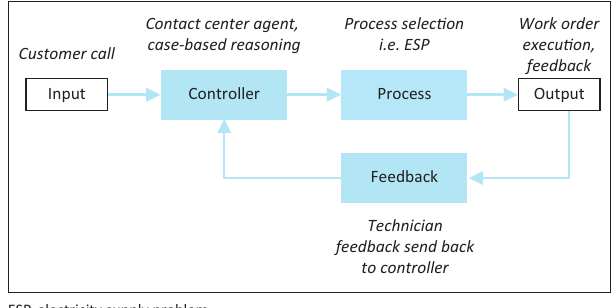
FIGURE 8: Closed-loop transaction data process.